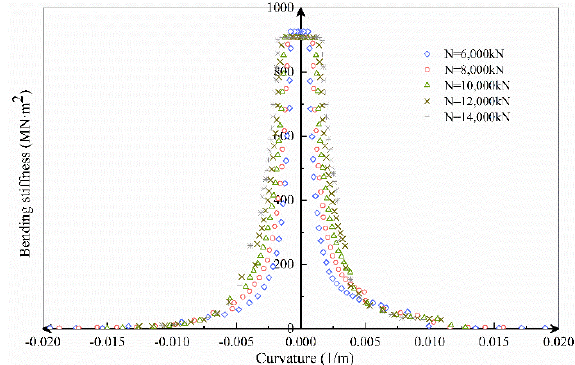
Figure 18. K θ – ϕ curves under different axial forces. Figure 18. K θ – φ curves under different axial